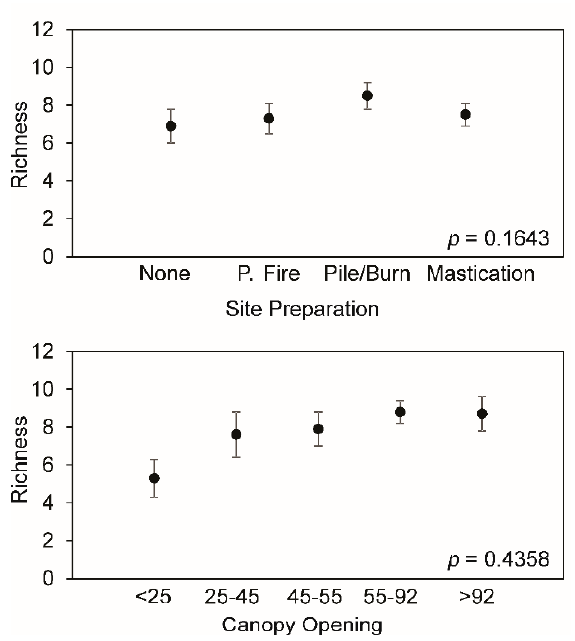
Figure 6. Vegetation diversity (richness) in relation to site preparation and canopy opening. Richness is the number of lifeforms and tree species present. Means and standard errors.